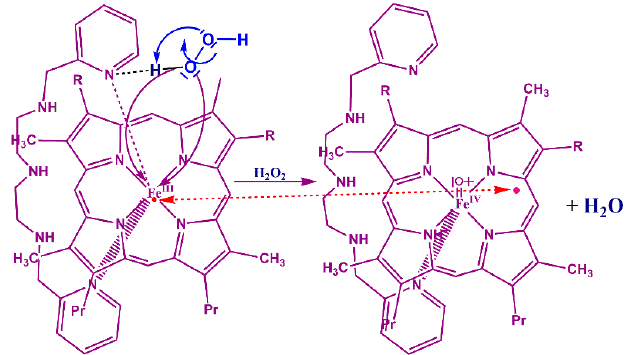
Scheme 2. The intermediate compound 0 formed faster if the Fe (III) has less stability to receive less